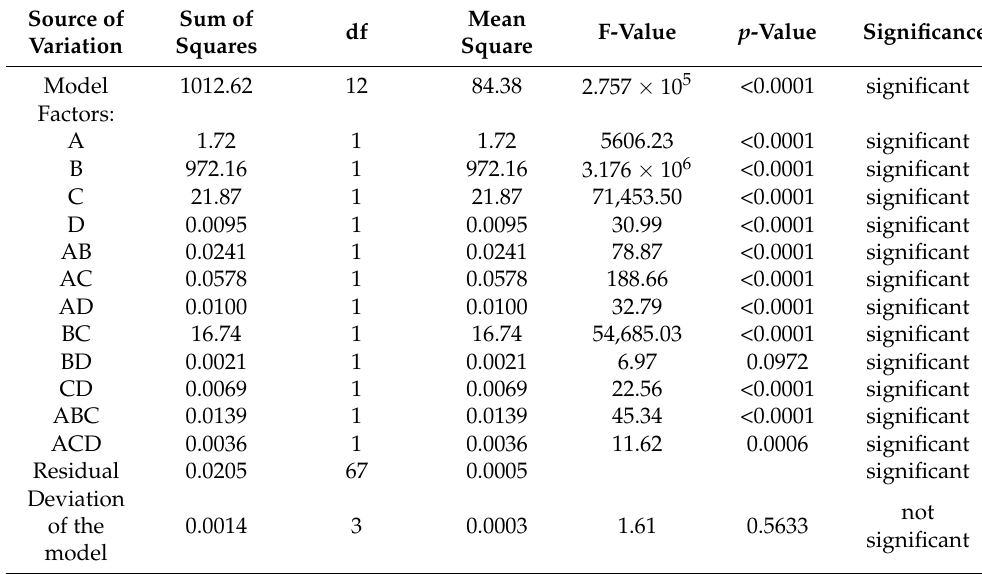
Table 4. ANOVA-Conwip.